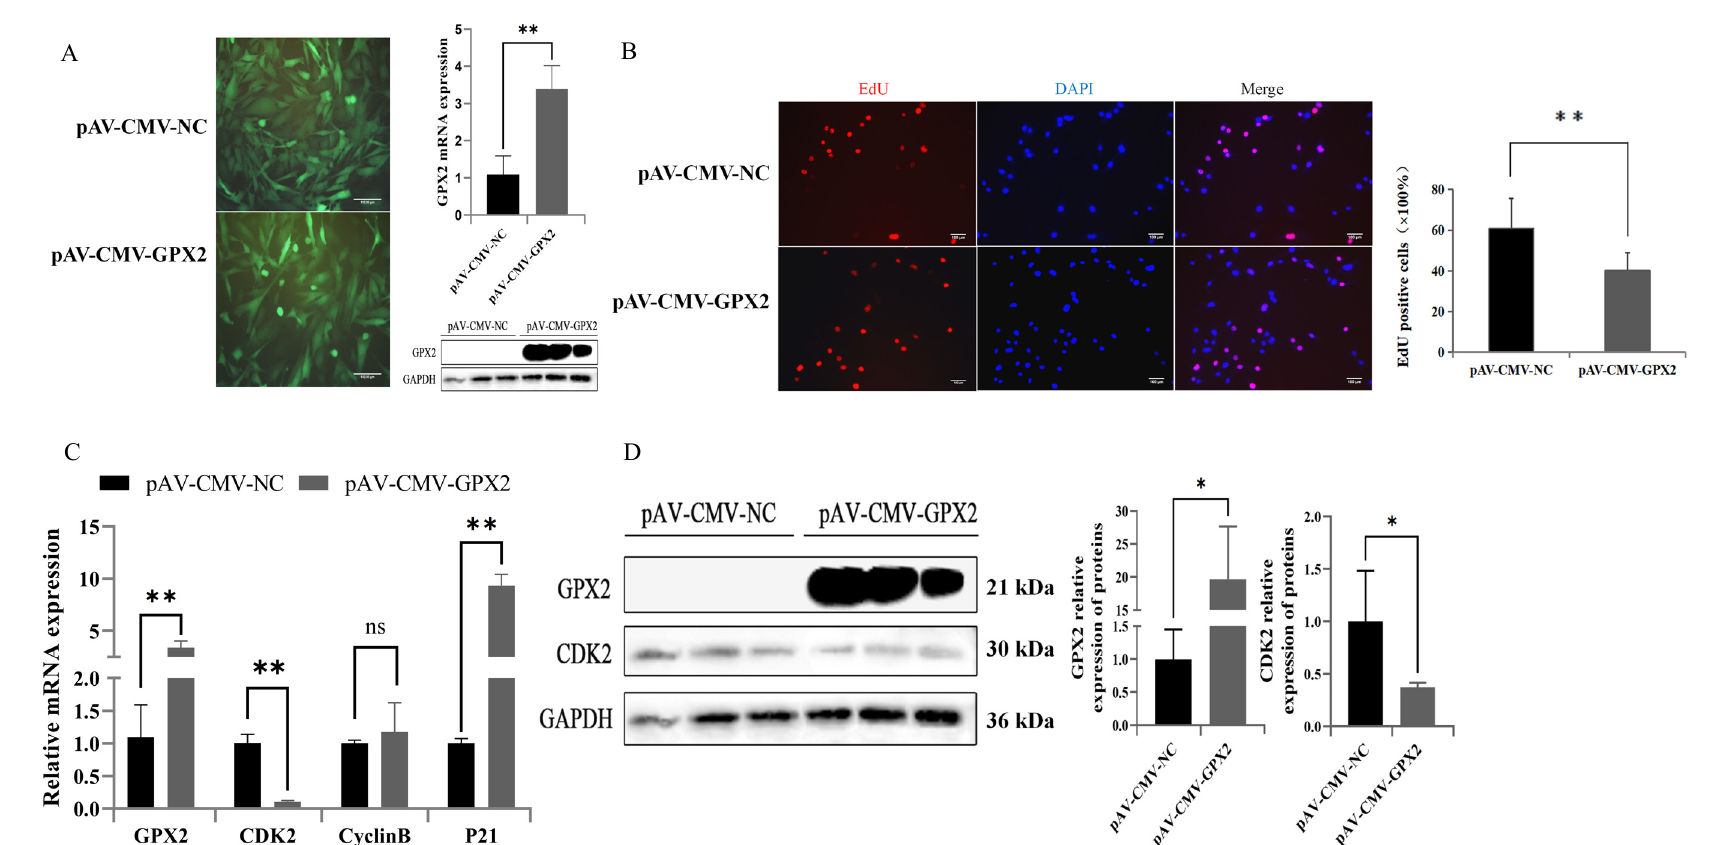
Figure 4. Overexpression of GPX2 inhibited the proliferation of 3T3-L1 cell. ( A ) 3T3-L1 infected with adenovirus carrying GPX2, and the mRNA and protein of GPX2 stable expressed in 3T3-L1 cell. ( B ) Representative immunostaining images comparing the cells in the proliferative phase from negative control and overexpression GPX2, the nuclei are stained with Hoechest 33342. Quantification graph showing the percentage of cells positive for the red cell (EdU). ( C ) mRNA expression of proliferation related gene between overexpression GPX2 and control group. ( D ) Protein levels and abundance analysis for GPX2 and CDK2 at 48 h after overexpression GPX2 in 3T3-L1 cell. * indicates p < 0.05, ** indicates p < 0.01, ns indicates not significant.